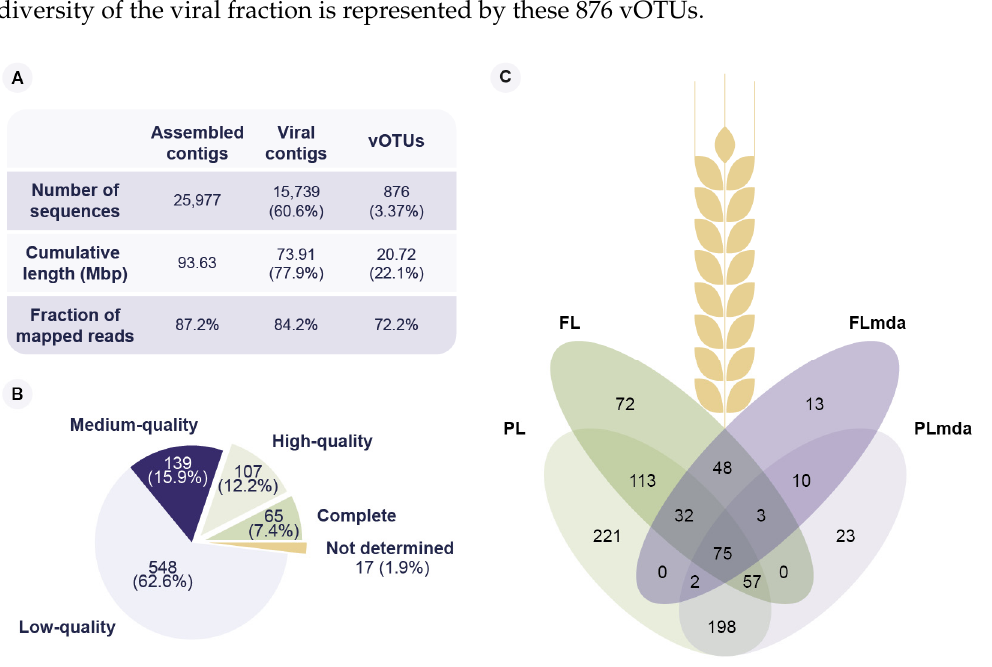
Figure 1. Virus operational taxonomic units (vOTUs) recovered from the four viral metagenomes from winter wheat leaves. Viral metagenomes from flag and penultimate leaves were sequenced without (FL, PL, respectively) and with MDA amplification (FL mda , PL mda , respectively). ( A ) Overview of total assembled contigs, identified viral contigs, and species-rank viral clusters (vOTUs), in terms of the number of contigs, cumulative contig length, and the fraction of mapped reads. ( B ) Predicted genome completeness of the recovered vOTUs. ( C ) Venn diagram of the presence of vOTUs in the four viral metagenomic